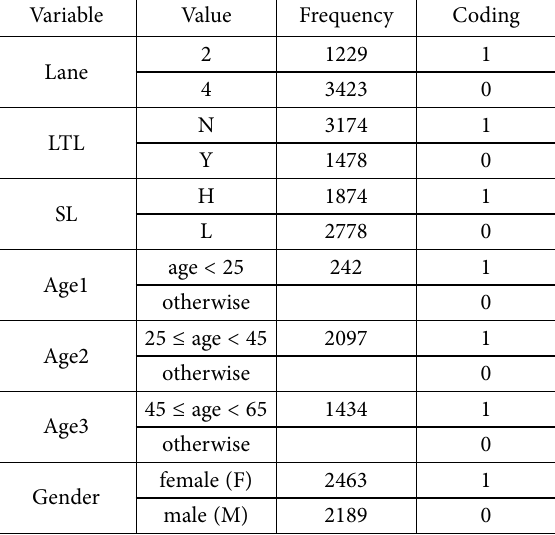
Table 3. Categorical variable values and coding in the model